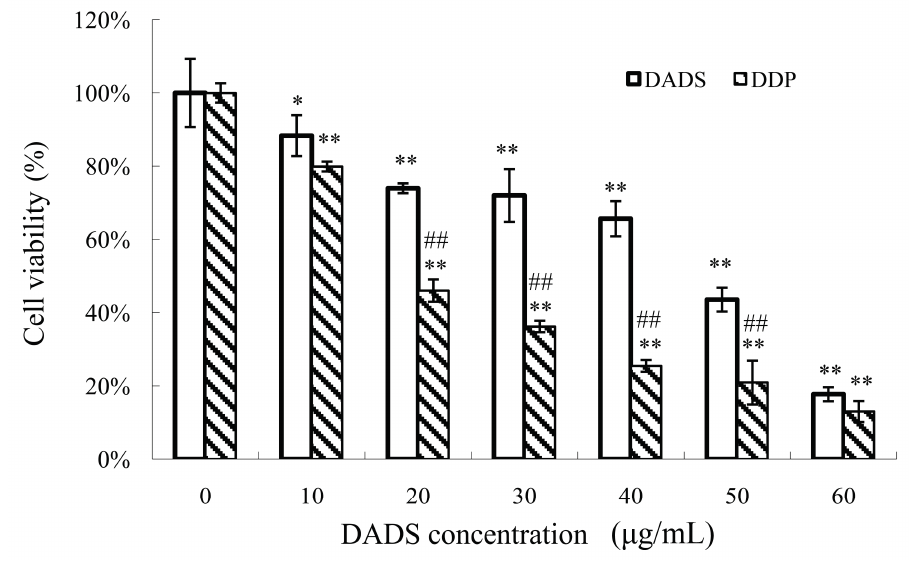
Figure 2. Viability inhibitory effects of DADS and cis -diammminedichloroplatinum (DDP) on ECA109 cells. ECA109 cells were incubated with different doses of DADS and DDP (0, 10, 20, 30, 40, 50, 60 μ g/mL) for 24 h respectively. Cell viability was detected by MTT assay and was represented as the percentage of relative absorbance. Data